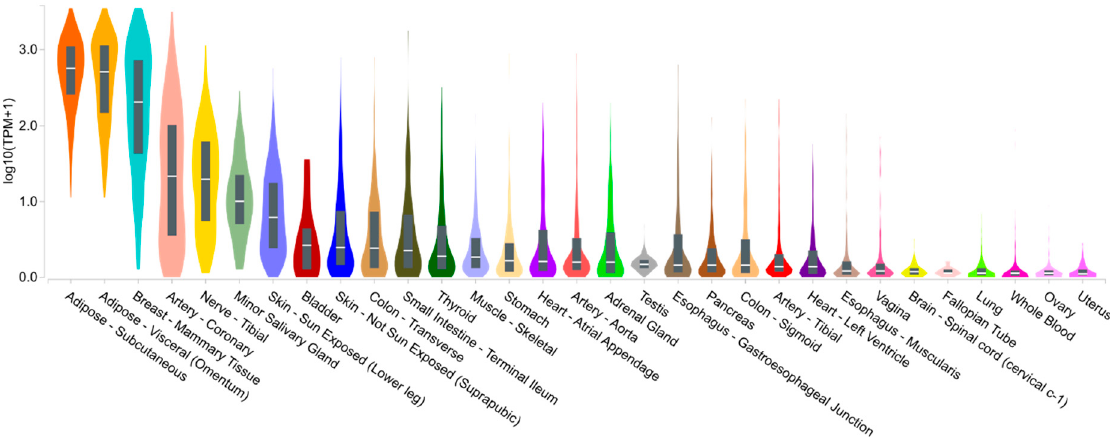
Figure 1. Gene expression of adiponectin—ADIPOQ (ENSG00000181092.9) in human tissues from the Genotype-Tissue Expression (GTEx) portal. The expression values are given in transcripts per million (log10 (TPM + 1)), calculated from a gene model with isoforms collapsed to a single gene. No other normalization steps were applied. Box plots are shown as median and as 25th and 75th percentile. Only tissues with the median TPM > 0.1 are presented.